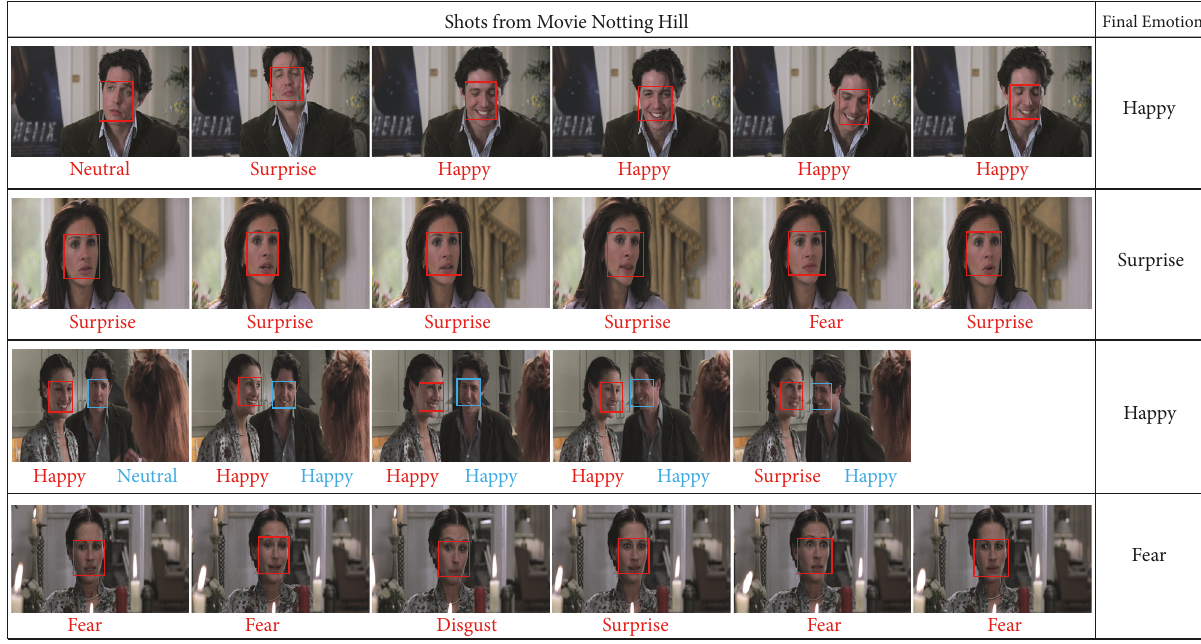
Figure 7: Sample shots from movie “ Notting Hill ” with emotional states predicted by our proposed